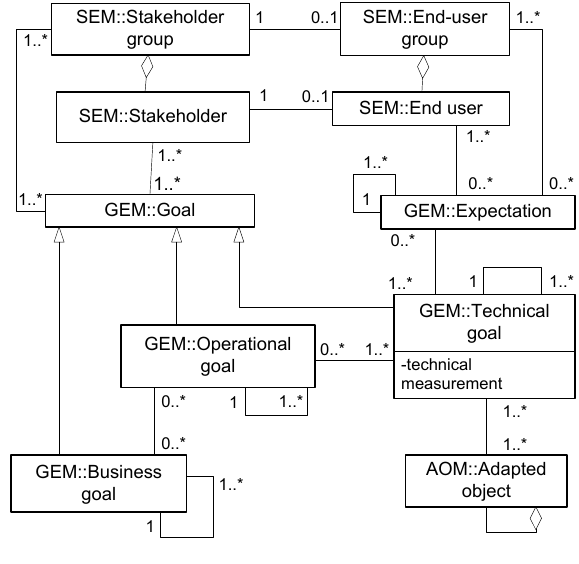
Figure 5. Goals and expectations in the